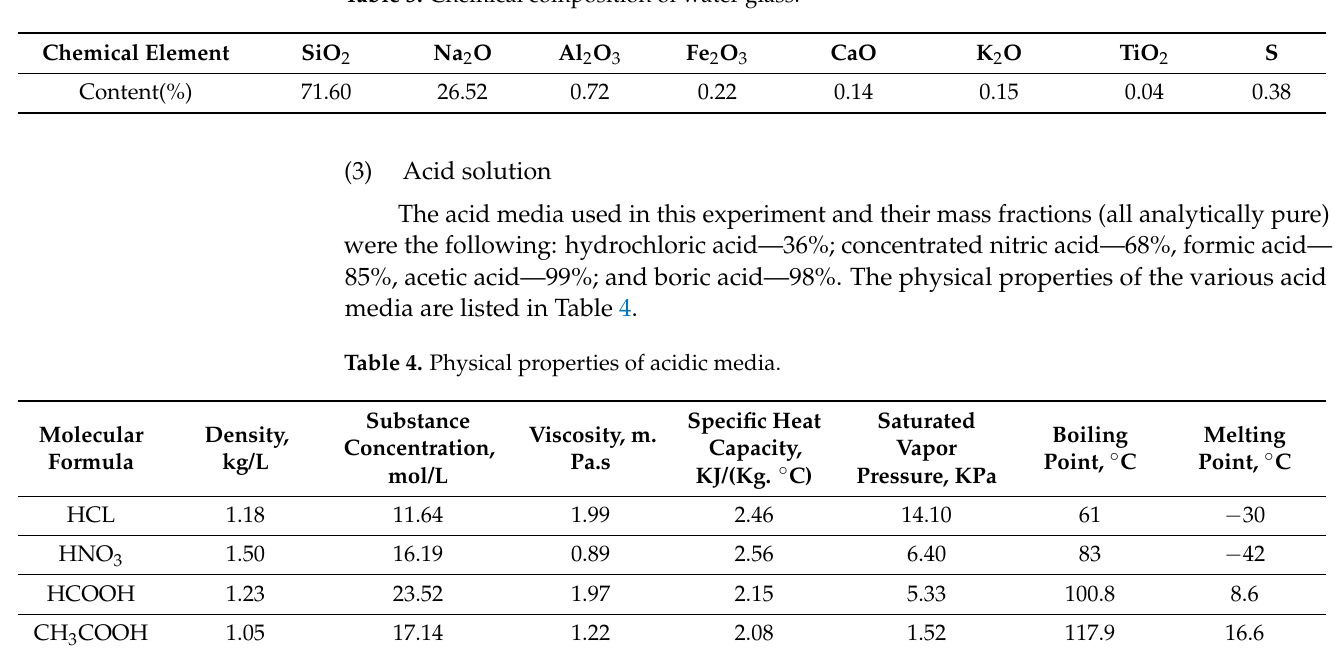
Table 3. Chemical composition of water glass.